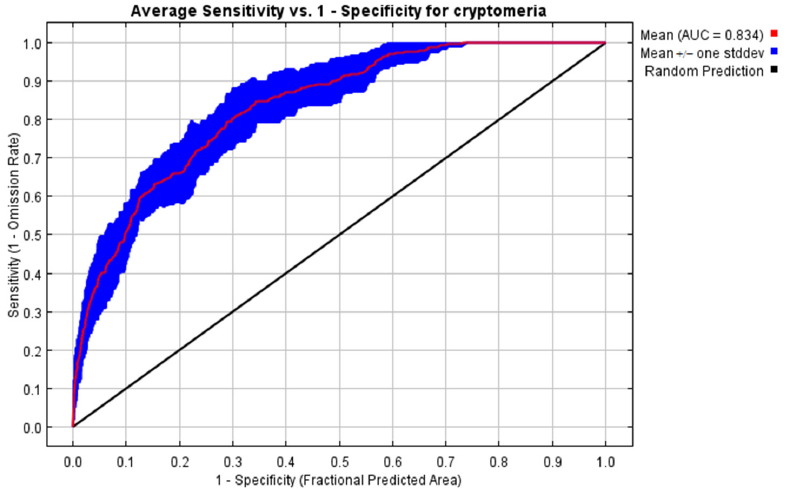
Figure 2. Receiver Operating Characteristic (ROC) curve for habitat suitability prediction of Cryptomeria fortunei.